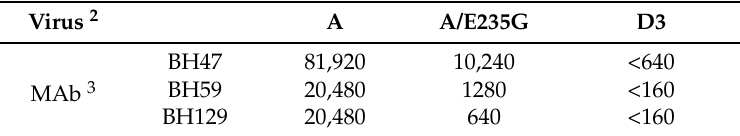
Table 4. Neutralizing titers of MAbs that recognize NE 1